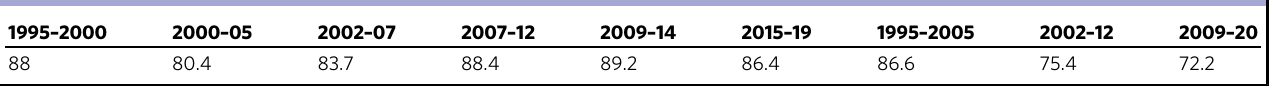
Table 2 Percentage of constrained portfolios that outperform unconstrained ones in total return.